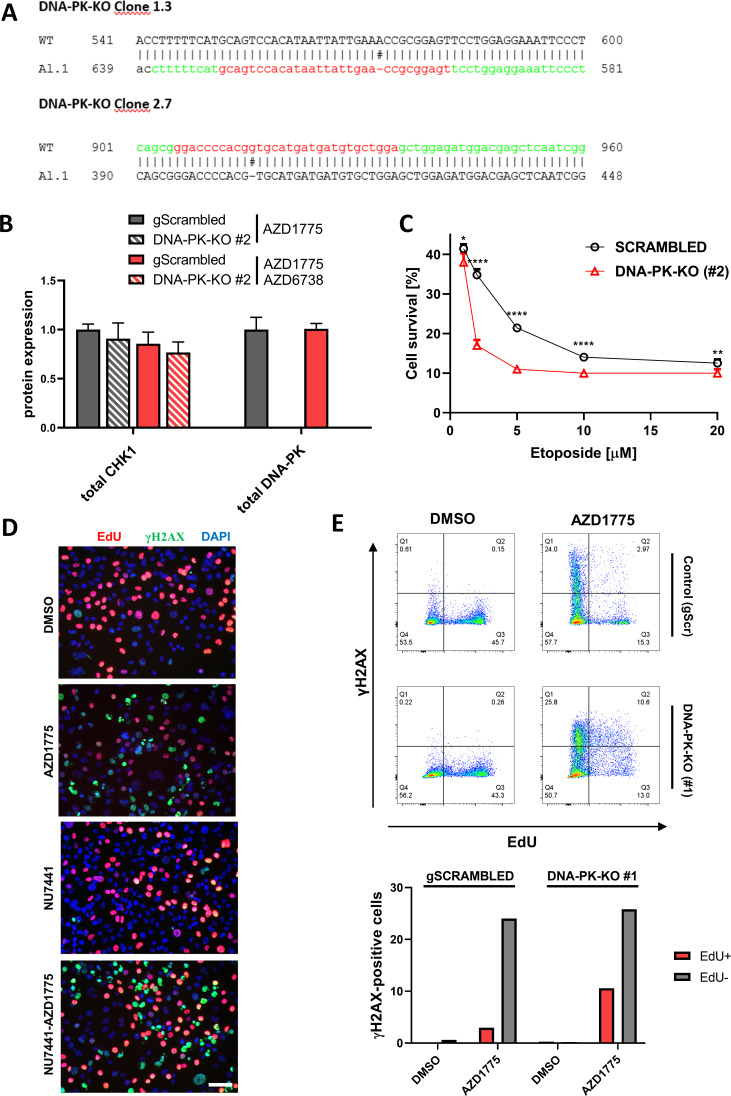
DNA-PK regulates recovery of replication and survival in response to AZD1775.(A) DNA sequencing confirming deletion of DNA-PK in MDA-MB-231 DNA-PK-knockout isogenic cell lines, clones #1.3 (#1) and #2.7 (#2). Region targeted by gRNAs was PCR-amplified and cloned into pTopo2.1 and sequenced, revealing presence of the same mutant allele resulting in frameshift mutations and premature stop codons in DNA-PK. Presence of only one allele was verified by mismatch-specific endonuclease-based genome editing detection kit (not shown). (B) Quantification of HCI-based analysis of CHK1 and DNA-PK in DNA-PK-deficient (clone #2) and DNA-PK-proficient (control) MDA-MB-231 cells treated with 500 nM AZD1775 or the AZD1775 (500 nM)-AZD6738 (1 μM) combination for 24 hr. (C) Cell viability assessment by crystal violet staining assay in response to 72 hr treatment with increasing concentrations of etoposide comparing MDA-MB-231 parental cells and DNA-PK-deficient cells (clone #2). *, ** and **** denote p-values obtained from Student’s t-test corresponding to <0.05,<0.01 and<0.0001 respectively. (D) Representative images related to Figure 5E. MDA-MB-231 cells were treated with the indicated inhibitors for 24 hr, spiked with EdU 1 hr prior to fixation and stained for EdU (red) and γH2AX (green). Scale bar = 60 μm. (E) Representative flow cytometry dot plots (upper panel) showing the distribution of EdU and γH2AX incorporation in MDA-MB-231 scrambled control and DNA-PK knockout cells (clone #1) treated for 24 hr with DMSO or AZD1775 (500 nM). Proportion of EdU-positive cells gated in the FACS plots and sub-divided according to γH2AX staining (lower panel, grey = EdU-, red = EdU+).